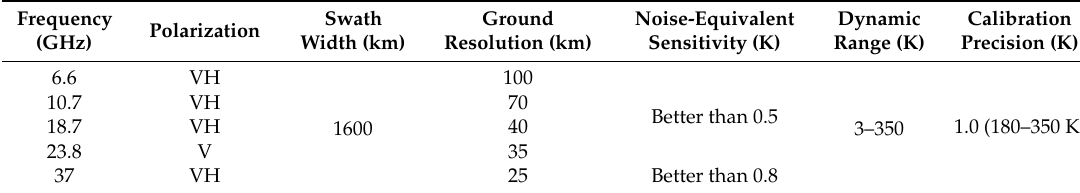
Table 3. The detailed parameters of the scanning microwave radiometer.